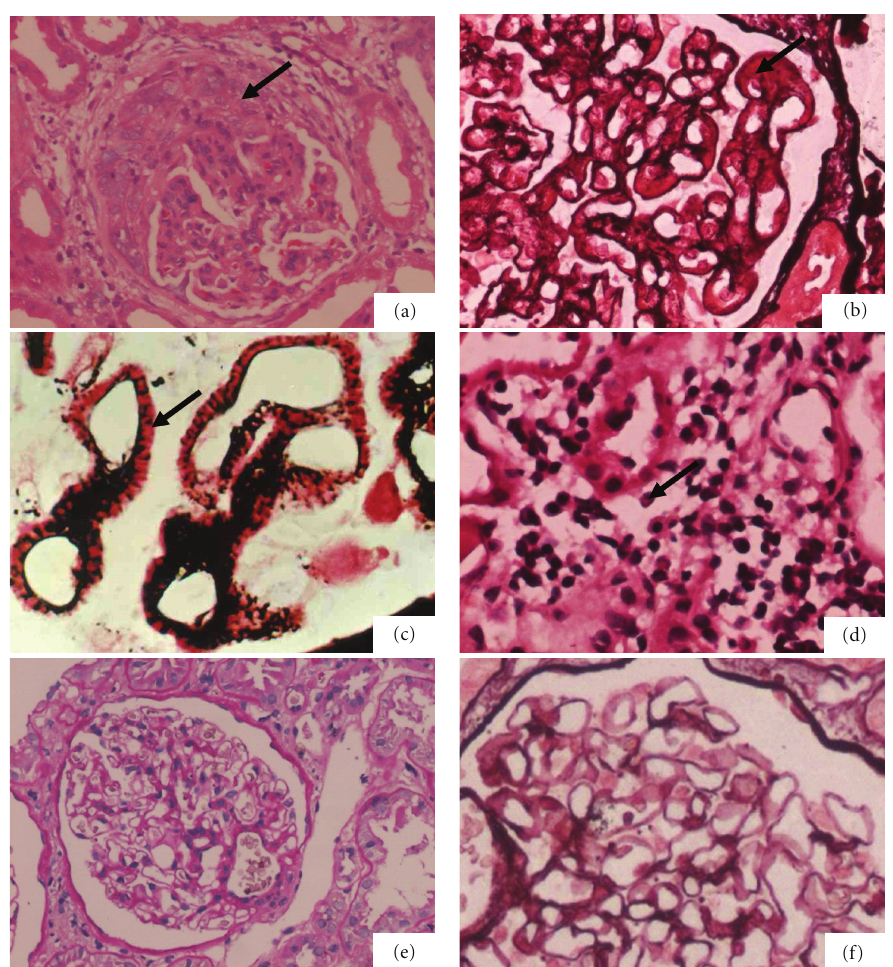
Figure 1: Features of the histopathology of active lupus nephritis. (a) Glomerular mesangial cells proliferation accompanied with cellular crescents (arrow showed). (HE staining, × 200). (b) Subepithelial immune deposits to form a “platinum ear” (arrow showed). (PASM staining, × 200). (c) Immune deposits in basement membrane. The “spikes bristle” can be observed in basement membrane (arrow showed). (PASM staining, × 1000). (d) Renal tubular epithelial cells shed accompanied with interstitial inflammatory infiltration (arrow showed). (HE staining, × 400). (e) Normal glomerulus without mesangial cells proliferation. (PAS staining, × 200). (f) Normal glomerulus without thick basement membrane. (PASM staining, ×